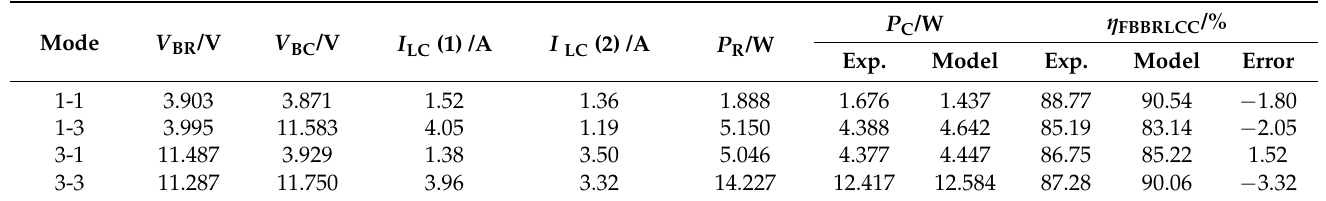
Table 5. Experimentally measured data of the proposed FBBRLCC equalizer in different operat- ing modes.